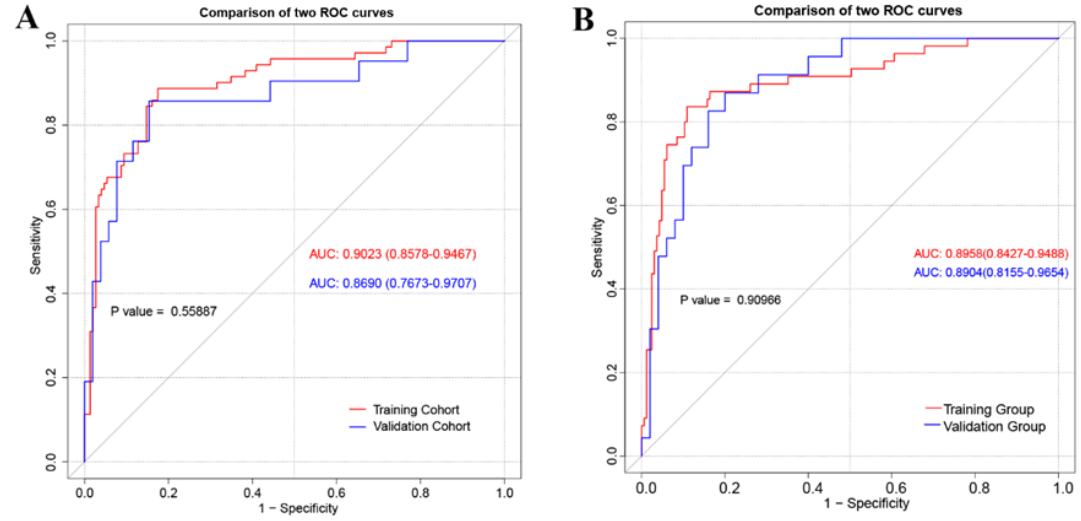
Figure 2. The receiver operating characteristic (ROC) curve of training cohort and validation cohort for PCa ( A ) and CSPCa ( B ). PCa: prostate cancer; CSPCa: clinically significant prostate cancer, defined as Gleason Grade ≥ 2; AUCs, areas under the ROC curve.